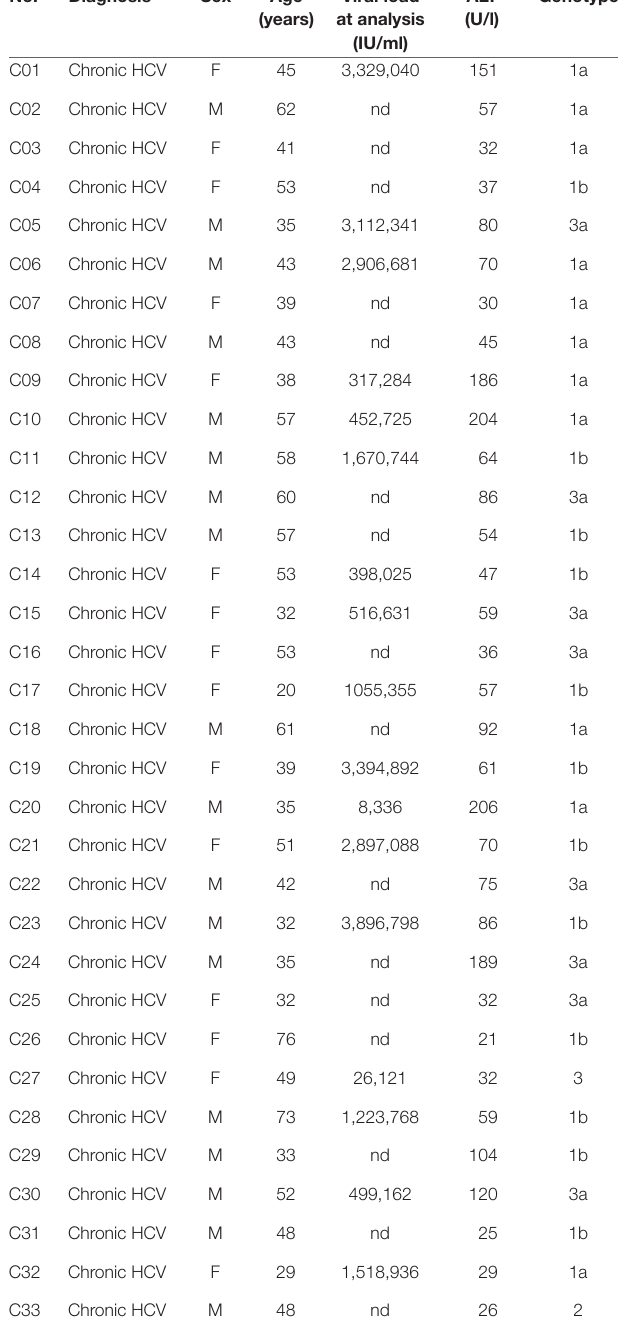
TaBle 1 | Characteristics of the hepatitis C virus (HCV) study